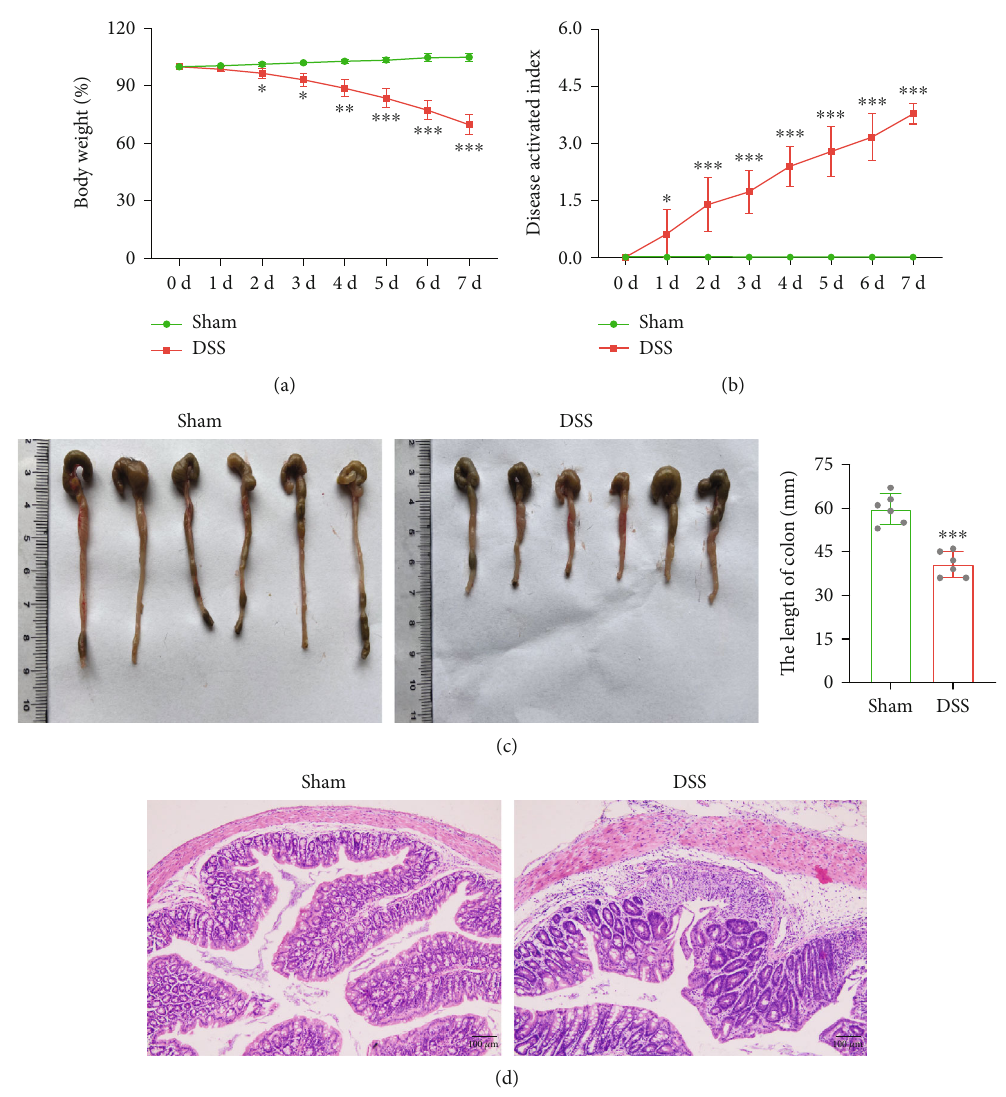
Figure 1: Clinical symptoms and in fl ammatory cell in fi ltration in mice with DSS-induced colitis. Mice were administered with 3.5% DSS to induce the model of colitis, and the sham group only received regular drinking water ( n = 6per group ). (a) and (b) The body weight and DAI scores were evaluated daily. (c) Mice were sacri fi ced, and the colons (from the cecum to proximal rectum) were collected. Representative images of the colon samples were displayed, and the average lengths of colon were determined. (d) H&E staining was performed on proximal colonic tissues, and the representative images of colon pathologic abnormalities were exhibited. ∗∗∗ p < 0 : 001 vs. sham group; scalebar = 100 μ m